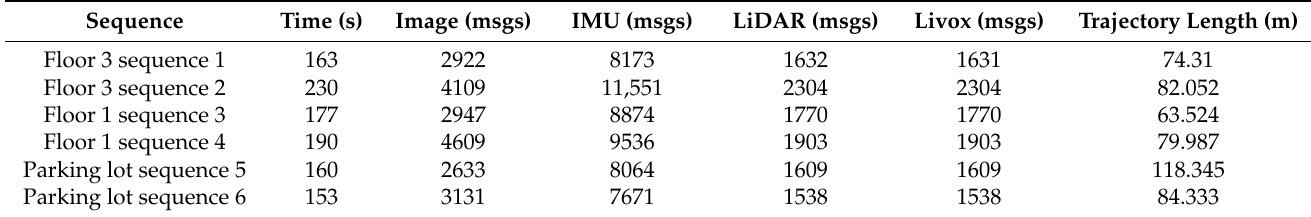
Table 2. Ceiling dataset sequence